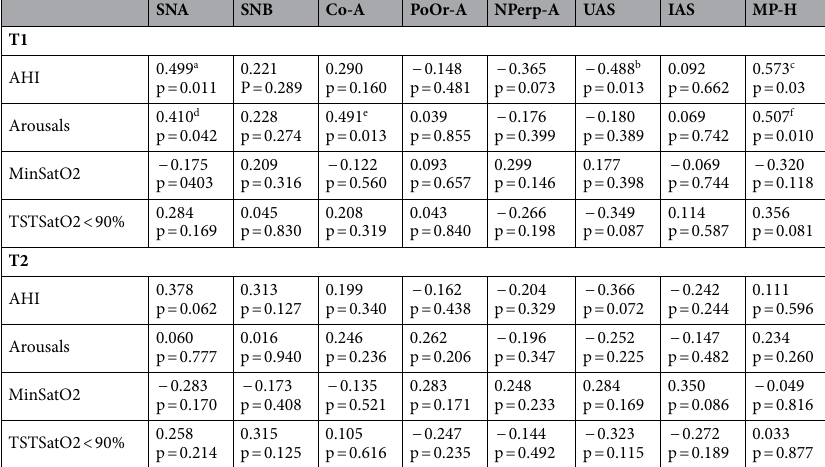
Table 7. Pearson’s correlations between AHI, Arousals, MinSatO2, TSTSatO2 < 90% and T1 and T2 cephalometric measures. SARME. Online Supplementary Figures: a-Figure 2; b-Figure 3; c-Figure 4; d-Figure 5; e-Figure 6; f-Figure